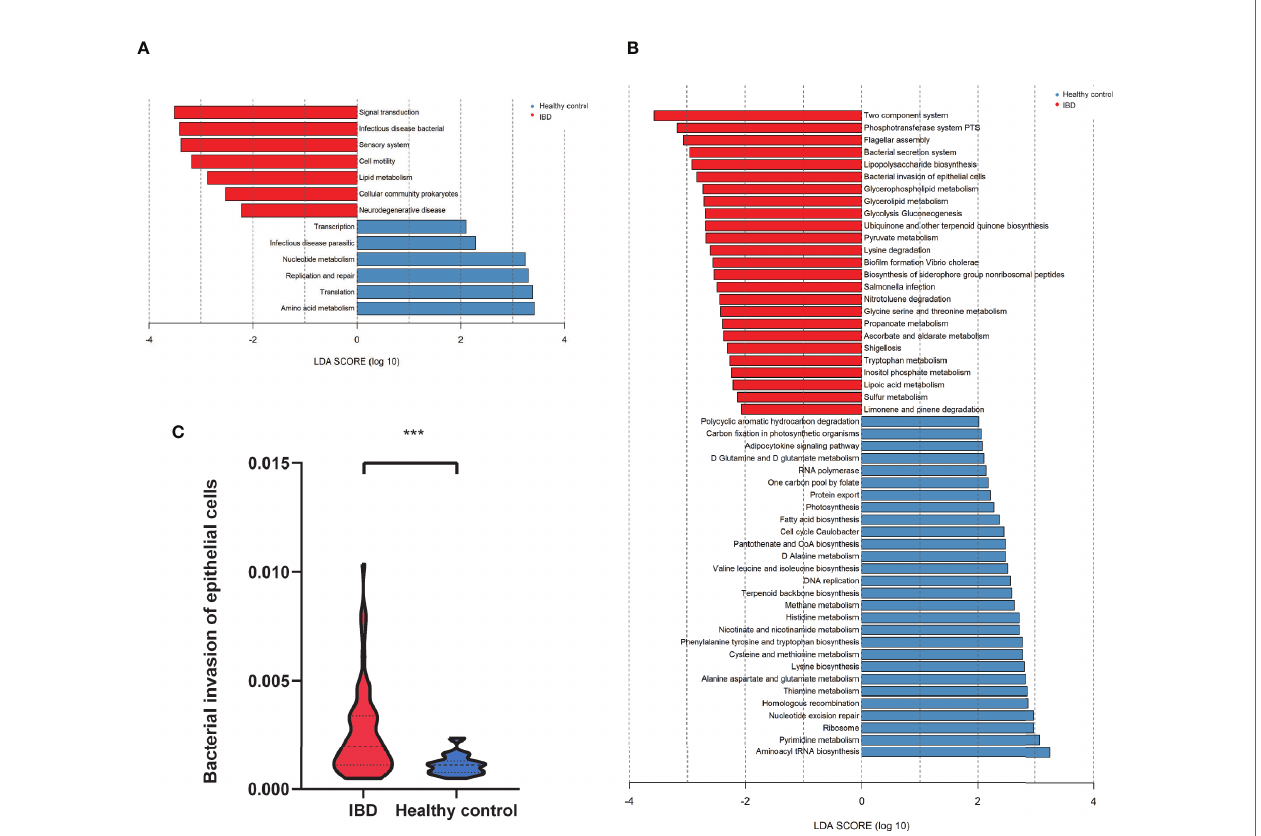
FIGURE 5 | The predicted functional module, based on gut microbiota. (A) KEGG pathway level2 analysis based on 16S rRNA (LDA>3). (B) KEGG pathway level 3 analysis based on 16S rRNA (LDA>2). (C) The abundant bacterial invasion of epithelial cells pathway between IBD and healthy control.